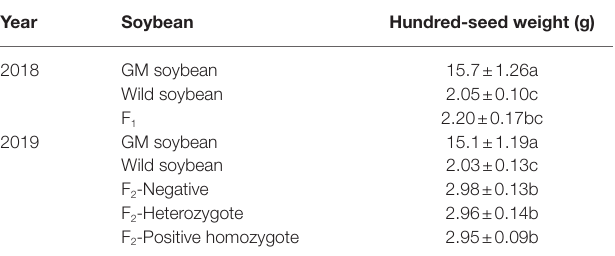
TABLE 6 | Correlation and interaction between fitness index, hybridization, and protein